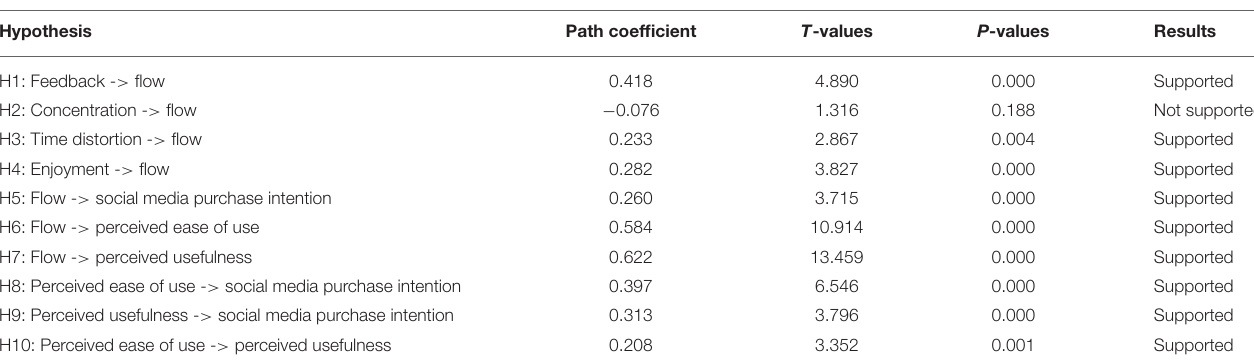
TABLE 3 | Hypotheses